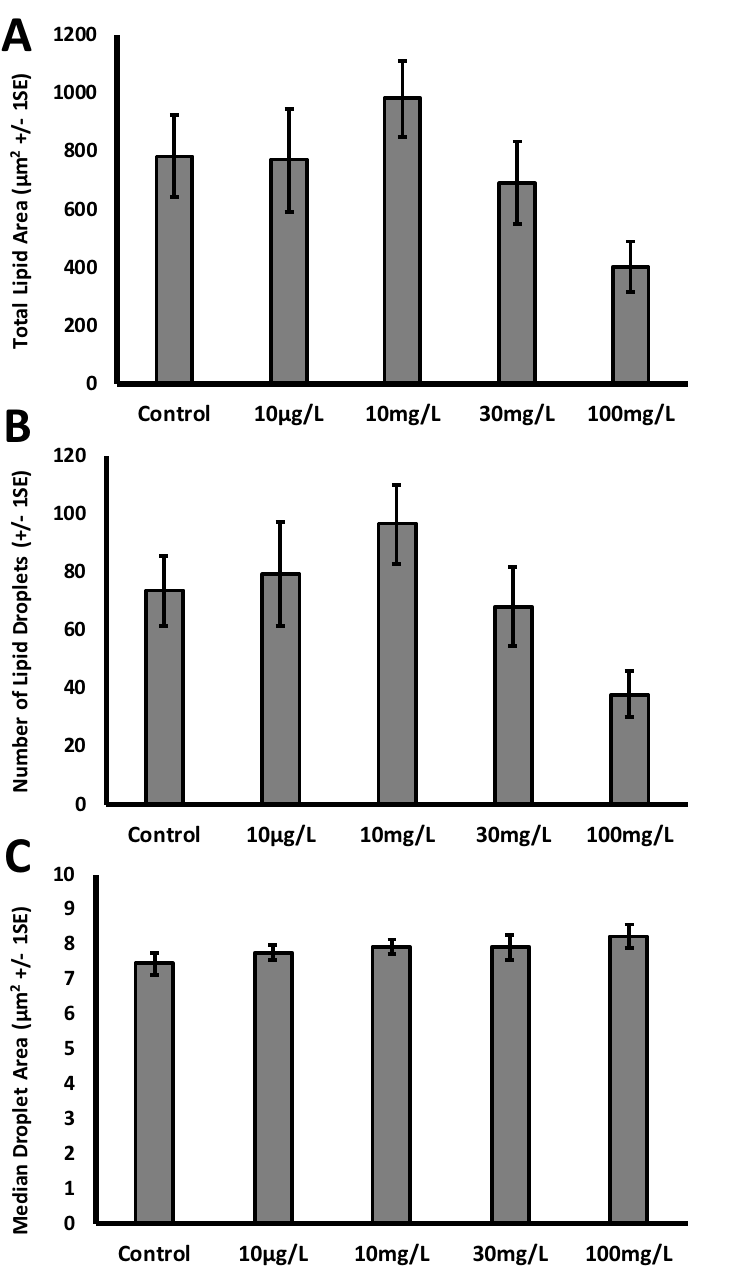
Fig 4. The livers of control and perchlorate-treated zebrafish do not differ in lipid accumulation, number of lipid droplets, or size of lipid droplets. A) Total lipid area in a section of liver. B) Number of lipid droplets in a section of the liver. C) Median size of lipid droplets in a section of the